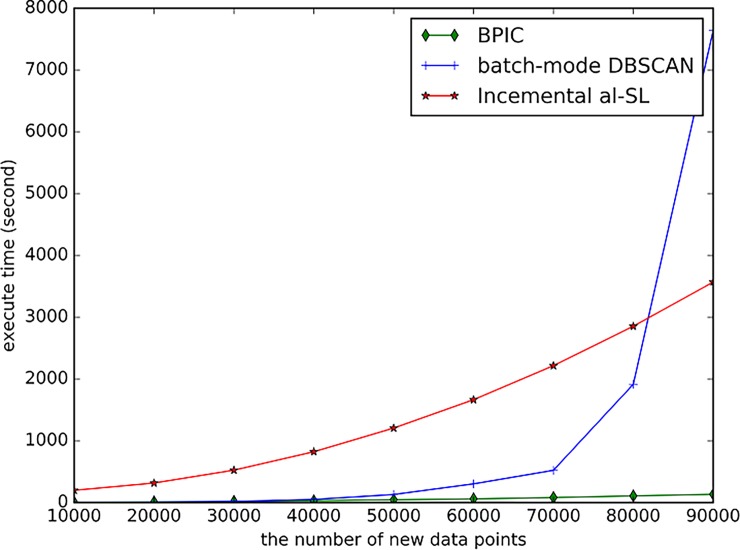
The execution time of the three methods against different numbers of new data points.